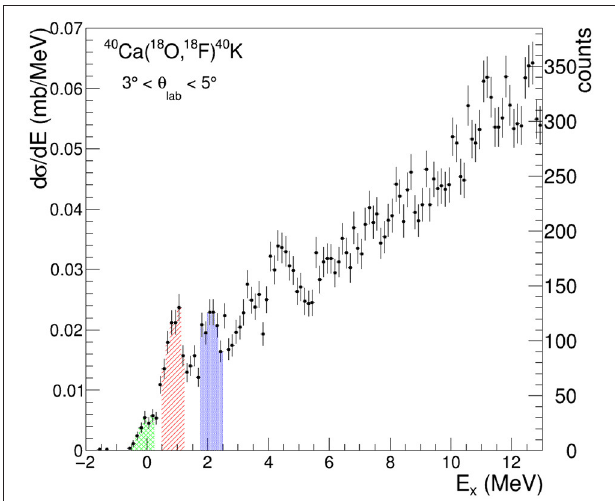
FIGURE 3 | Excitation energy spectrum of the 40 Ca( 18 O, 18 F) 40 K charge exchange reaction at 275 MeV and 3 ◦ < θ lab < 5 ◦ . The three hatched areas indicate the regions of interest for the study of the angular